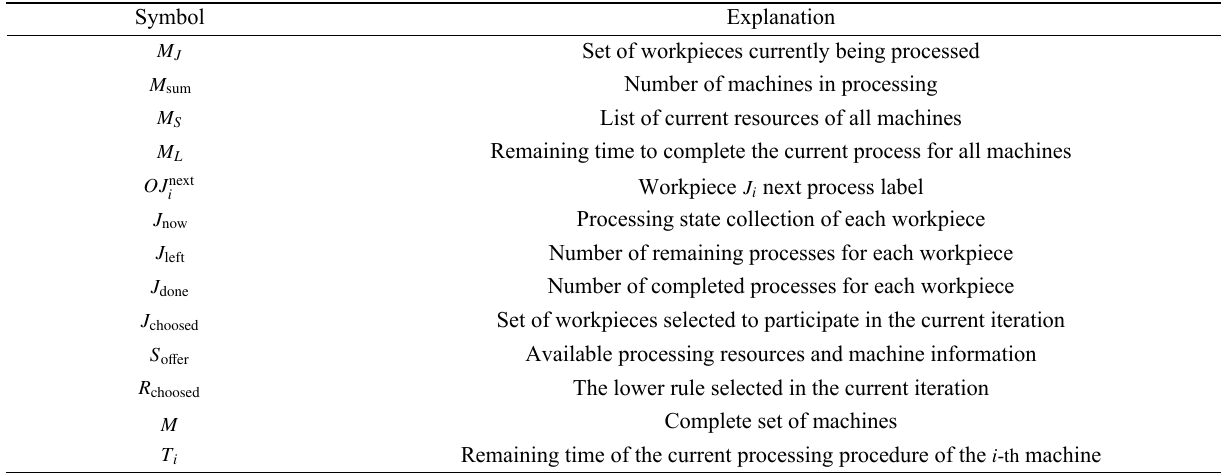
Table 2 State parameter